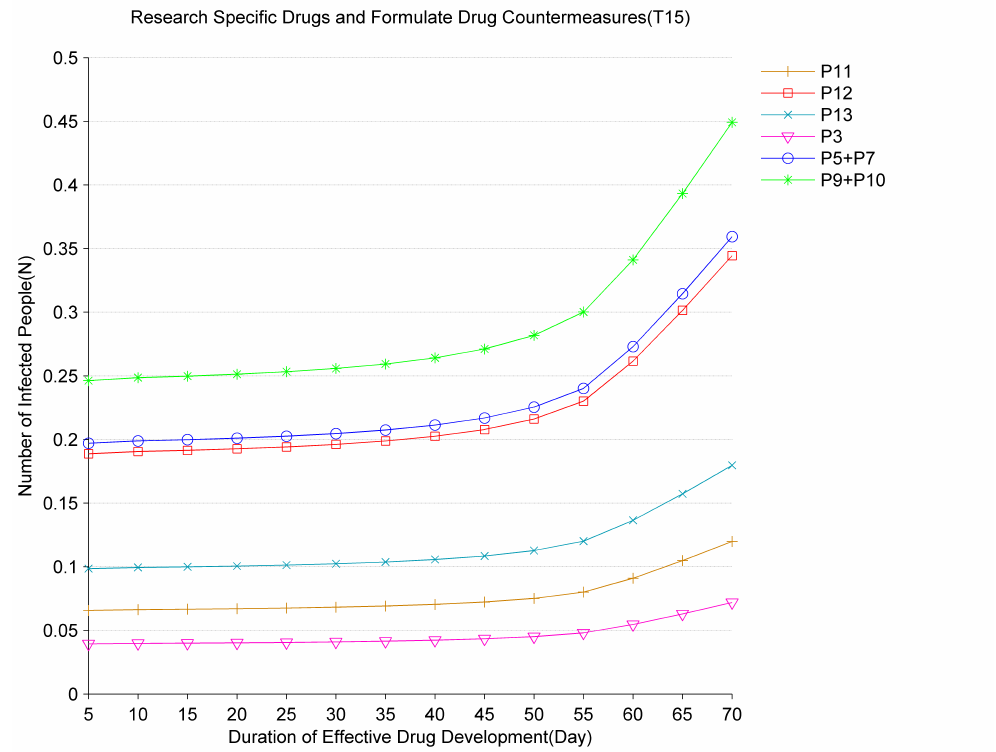
Figure 11. Relationship between duration of specific drugs development and the number of in- fected